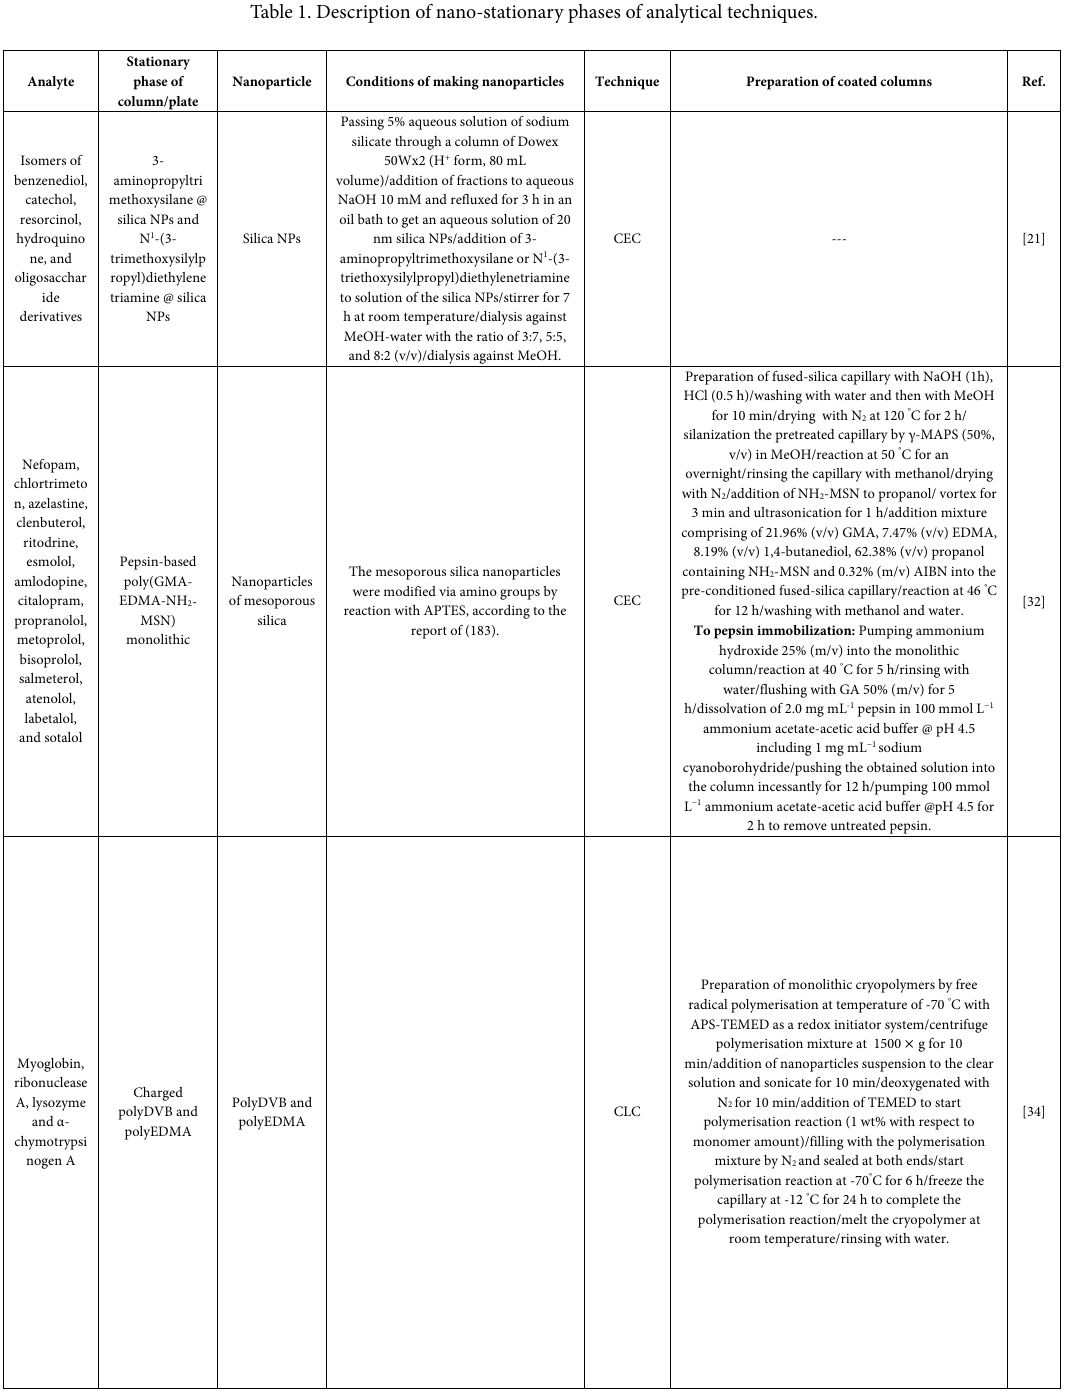
solution and sonicate for 10 min/deoxygenated with N 2 for 10 min/addition of TEMED to start polymerisation reaction (1 wt% with respect to monomer amount)/filling with the polymerisation mixture by N 2 and sealed at both ends/start polymerisation reaction at -70 ° C for 6 h/freeze the capillary at -12 ° C for 24 h to complete the polymerisation reaction/melt the cryopolymer at room temperature/rinsing with water.